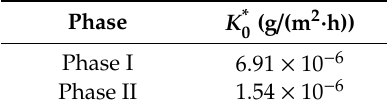
Table 3. Apparent glass dissolution rate